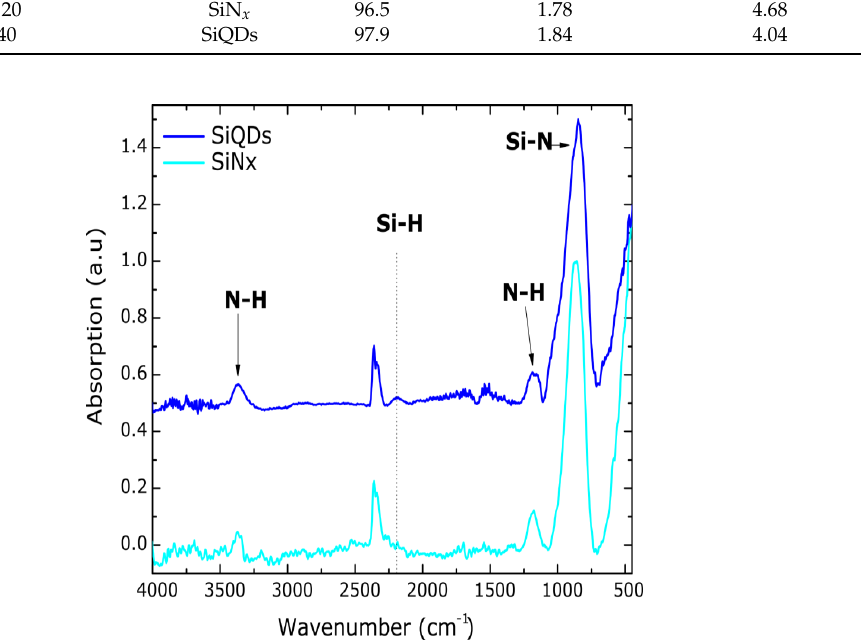
Figure 2. FTIR spectra for the two different NH 3 flow rates used to attain silicon quantum dots (SiQDs) and non-radiative silicon nitride (SiN x ) films. The band at 2360 cm − 1 corresponds to the CO 2 molecule in the operating environment.